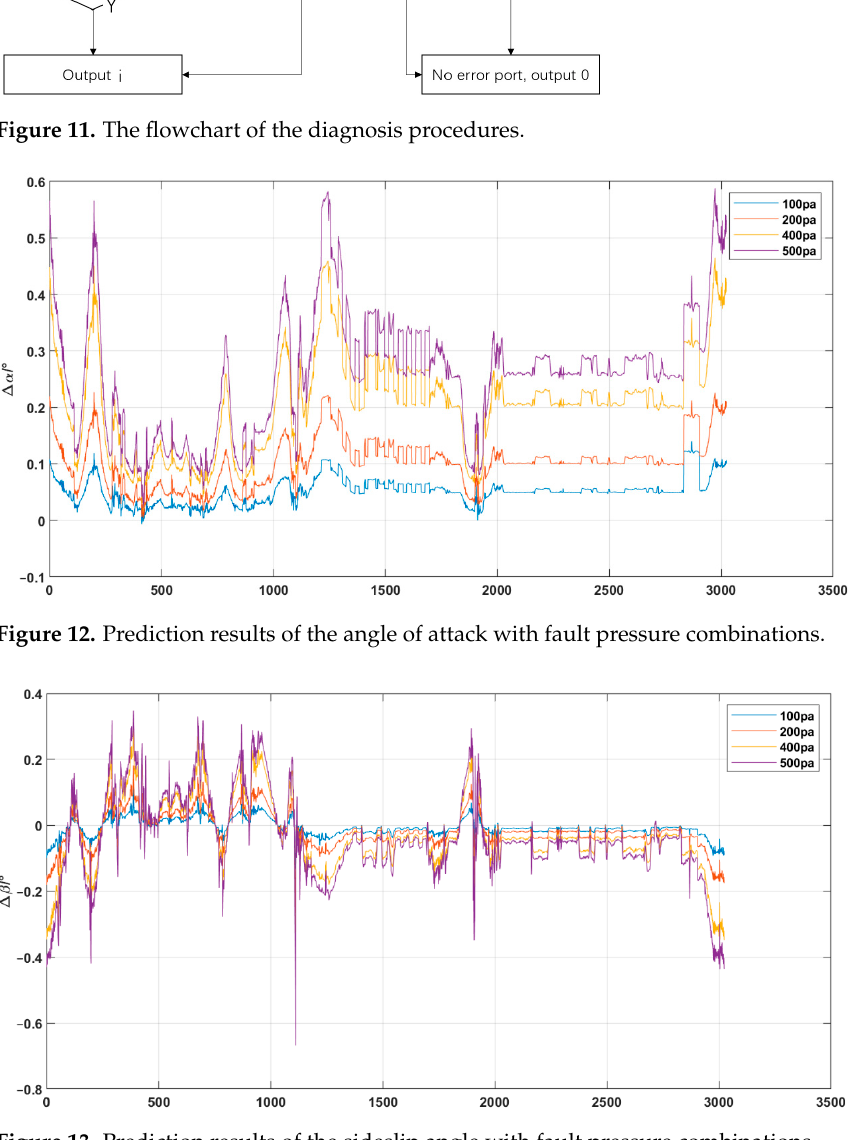
Figure 13. Prediction results of the sideslip angle with fault pressure